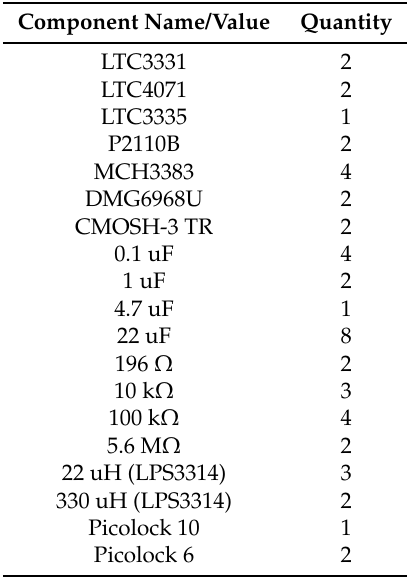
Table 2. Table with the components used on the energy management board